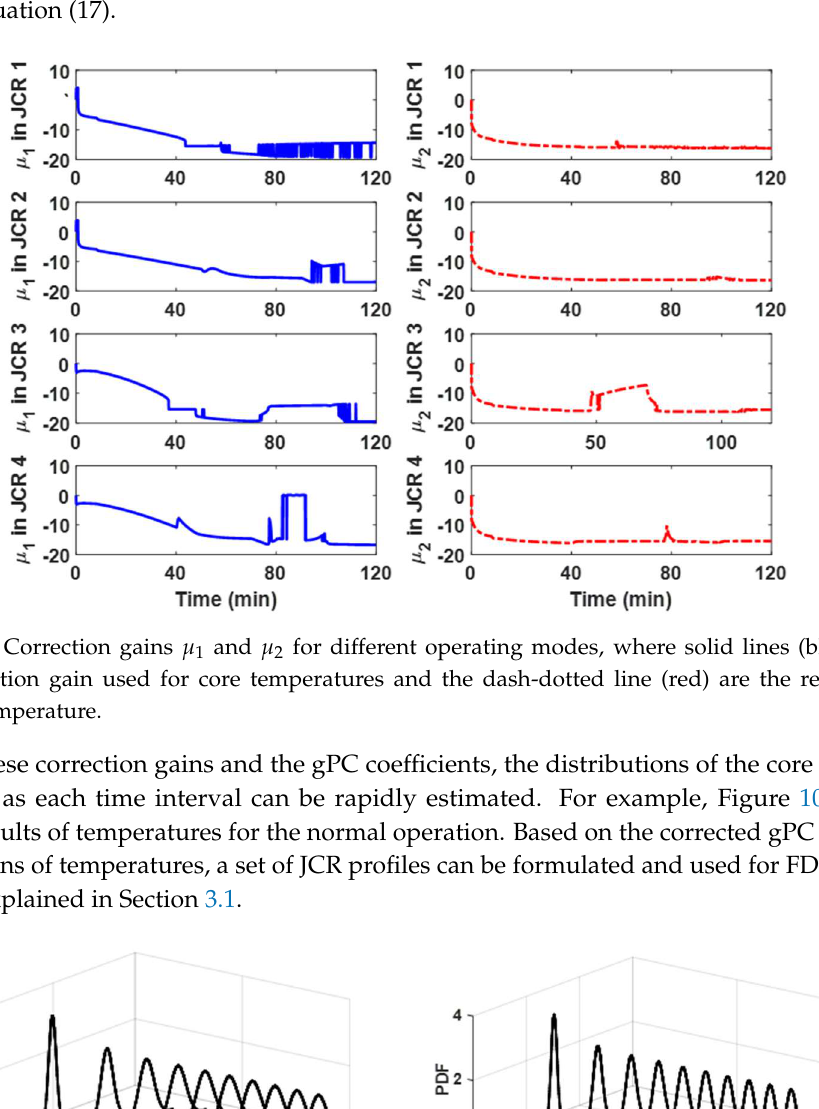
Table 3. Faults classification rate with different joint confidence region (JCR) profiles.